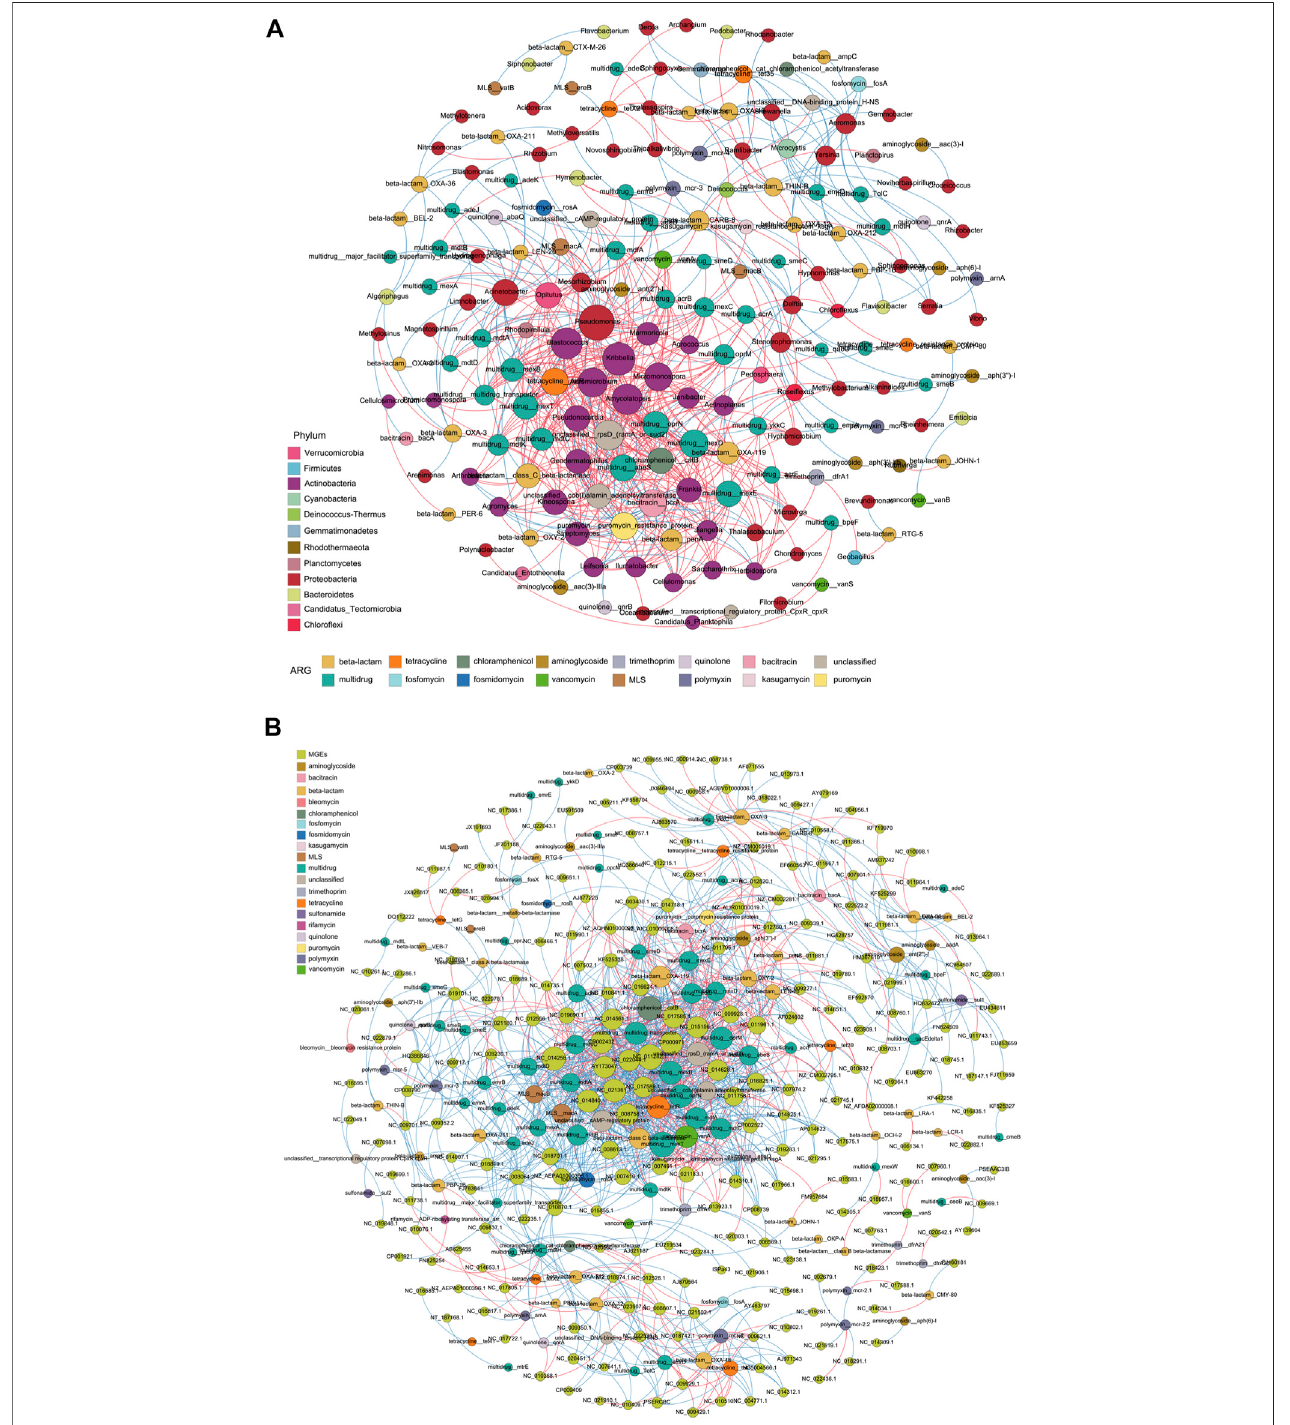
FIGURE 8 | Correlation between ARGs and bacteria, and ARGs and MGEs based on network analysis. Co-occurrence patterns between the bacteria and ARG subtypes (A) ; ARG subtypes and MGEs (B) . The red line indicates a positive correlation between two nodes. The blue line represents a negative correlation. The size of each node is proportional to its number of